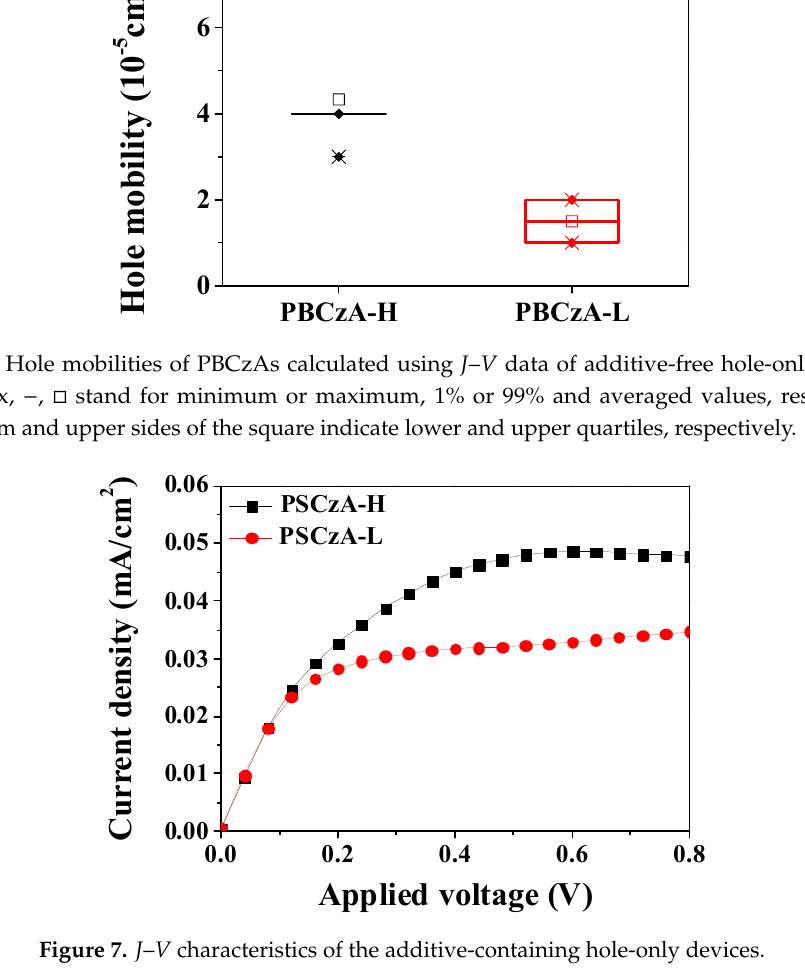
Figure 8. Nyquist plots of EIS spectra for the ssDSCs with PBCzA-H and PBCzA-L, measured at − 0.7 V in the dark. Inset shows the equivalent circuit for ssDSC.